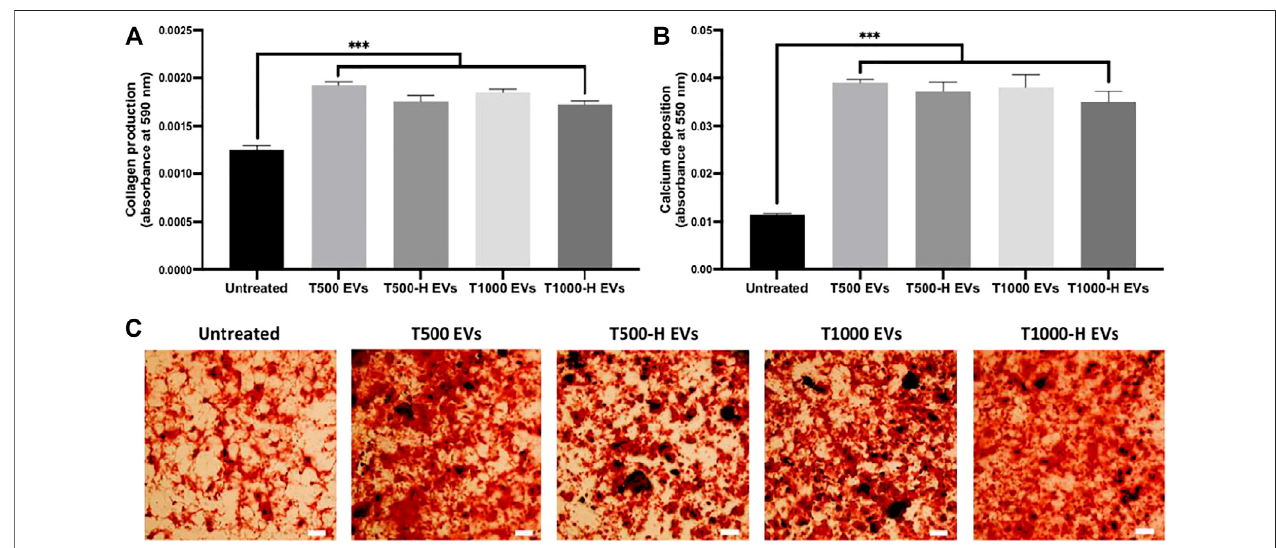
FIGURE 7 | The in fl uence of nnHA scaffold coating on osteoblast-derived EVs osteoinductive ef fi cacy. (A) Collagen production and (B) , (C) calcium deposition following 21 days of osteogenic culture. Black staining indicates mineral nodules. Scale bar (cid:2) 200 µm. Data are expressed as mean ± SD (n (cid:2) 3). ***P ≤ 0.001.